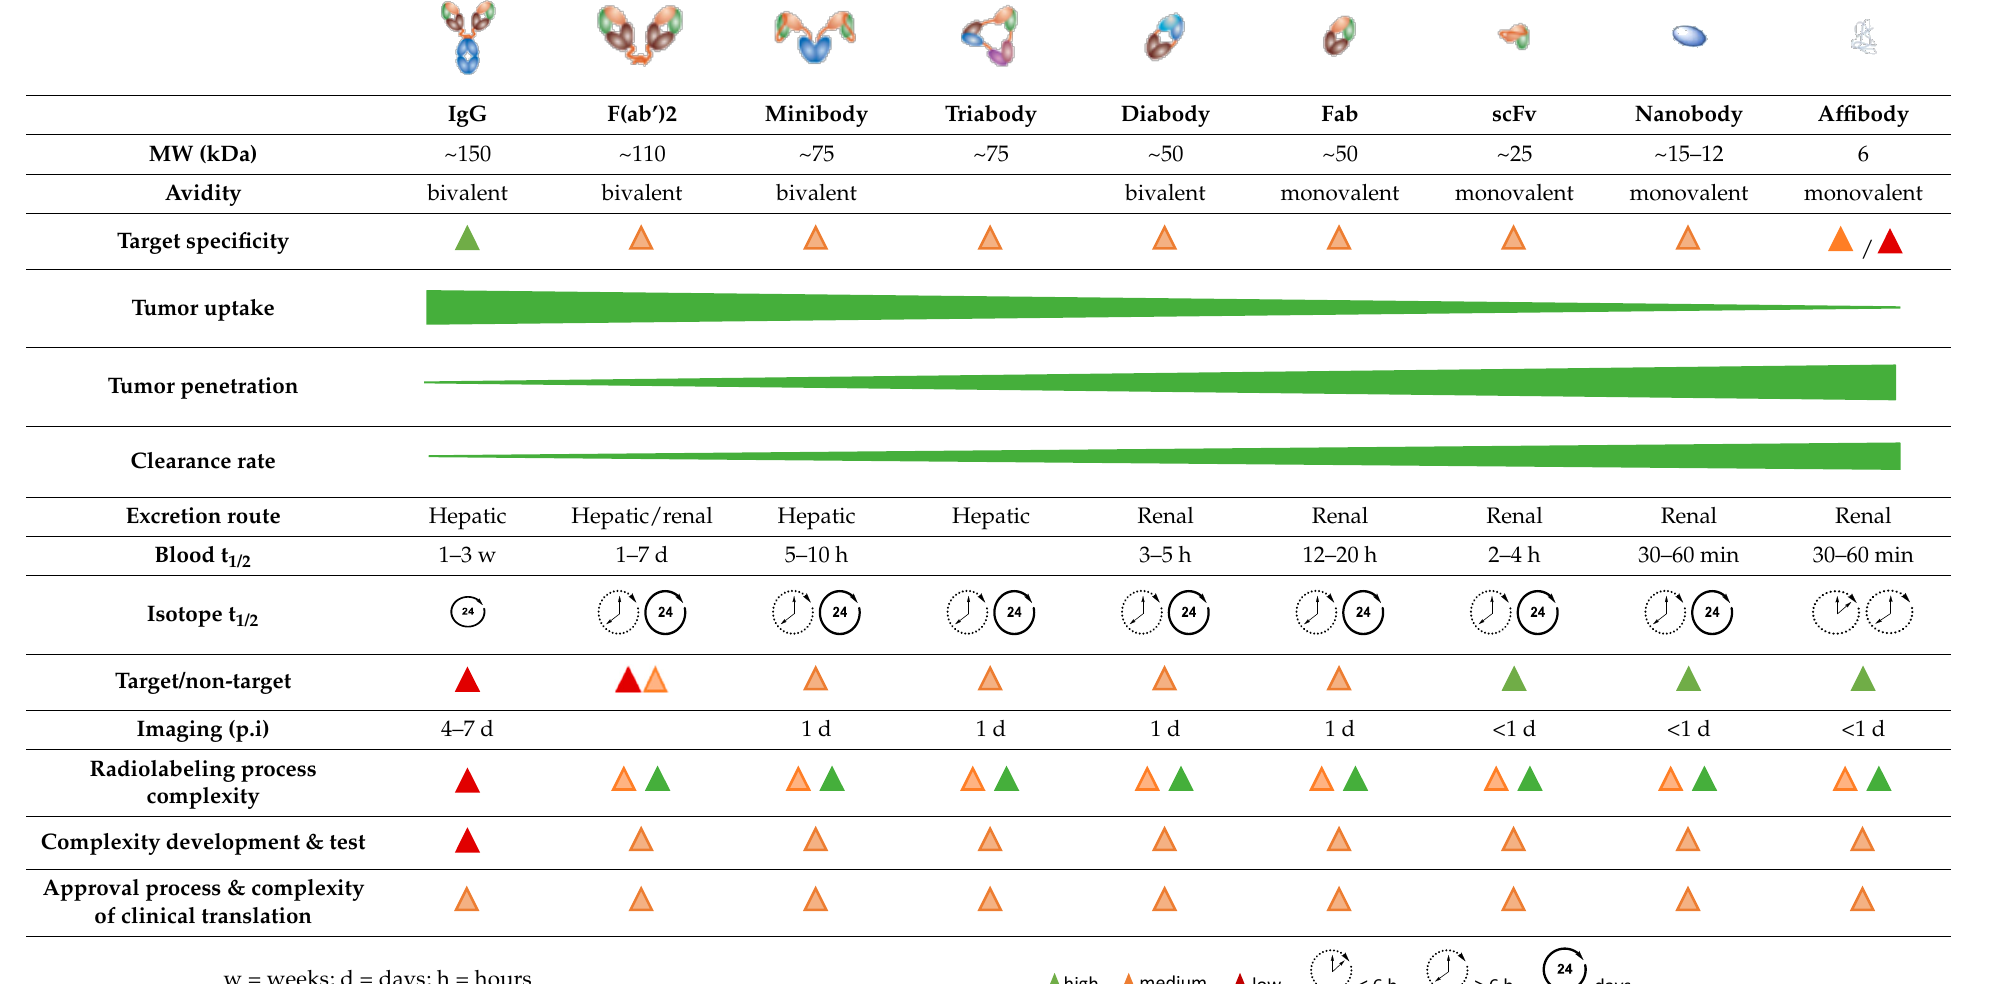
Table 3. Summary of the key properties of intact antibodies, antibody fragments, nanobodies, and affibodies [10,17].